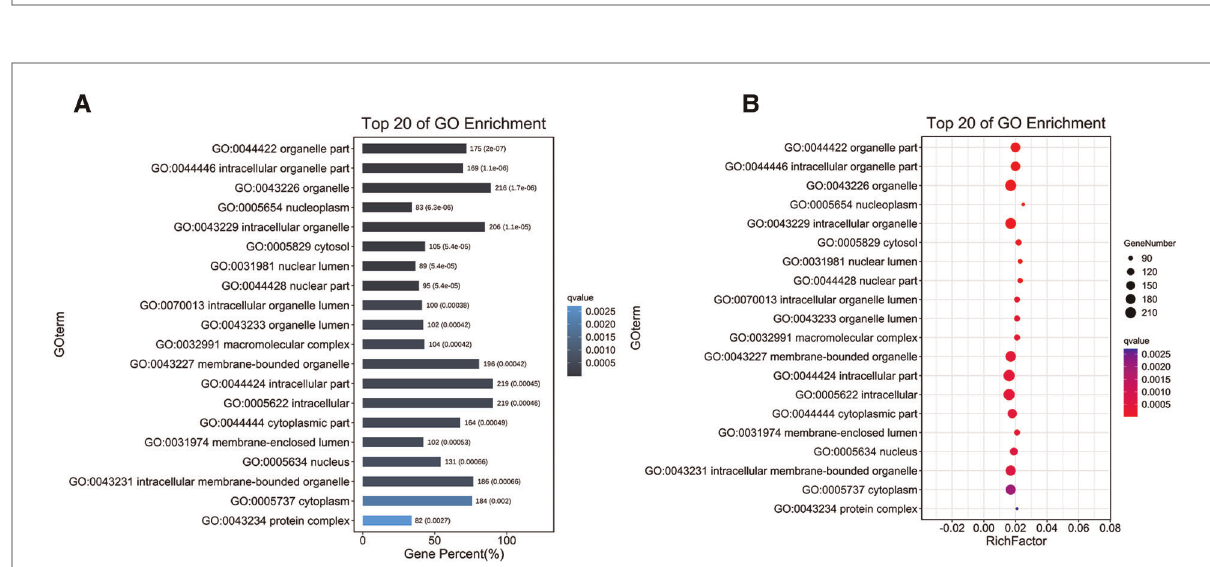
FIGURE 3 Go enrichment analysis of circRNA expression in wound tissues of diabetic patients. ( A ) The fi rst 20 GO term entry columns with differential expression of circRNAs in diabetic wound tissues, GO with level 2 coordinates at the abscissa, and term enriched by each term. ( B ) GO enrichment analysis of differentially expressed cirRNAs in wound tissues of diabetic